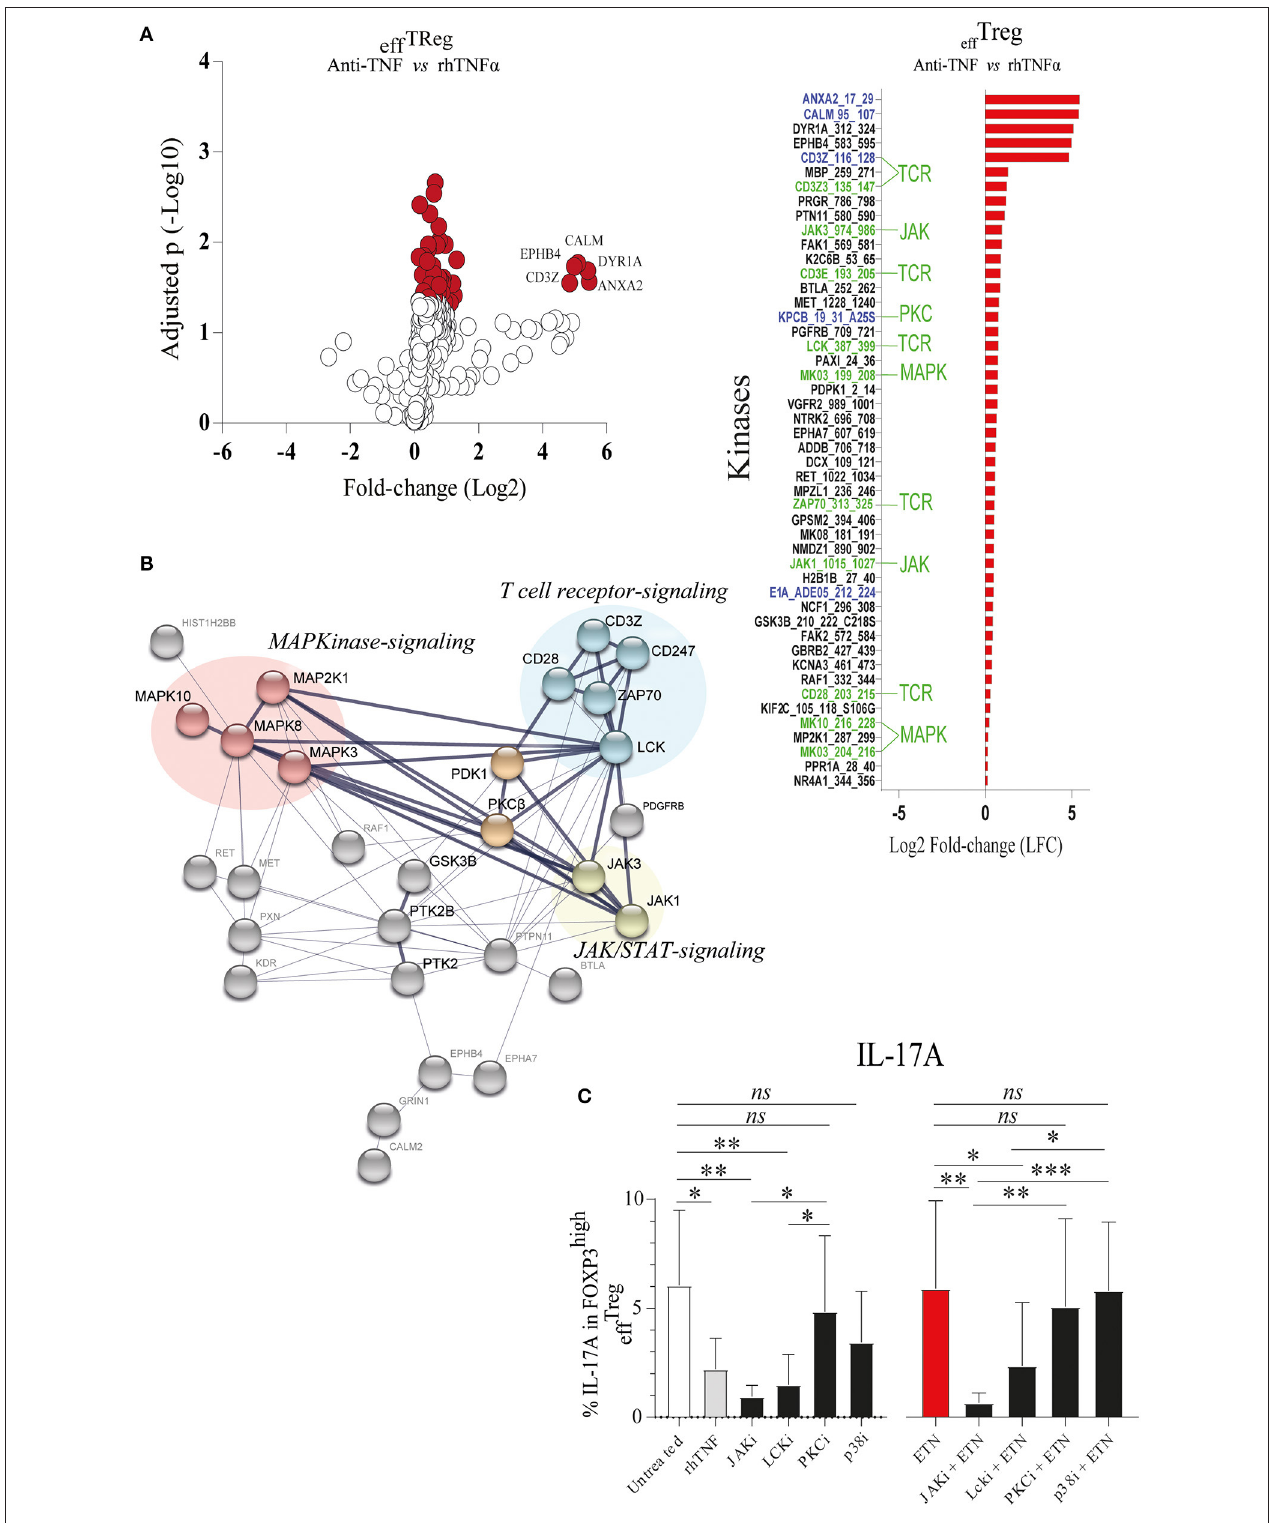
FIGURE 3 | TNF α signaling in eff Treg suppresses TCR and JAK kinase activity, leading to regulation of IL-17A expression. eff Treg were stimulated with α CD3/CD28 beads and rh-IL-2 in the presence of rhTNF α or anti-TNF. On day 4, phosphoserine/threonine kinase (STK) and phosphotyrosine kinase (PTK) activity of cells were